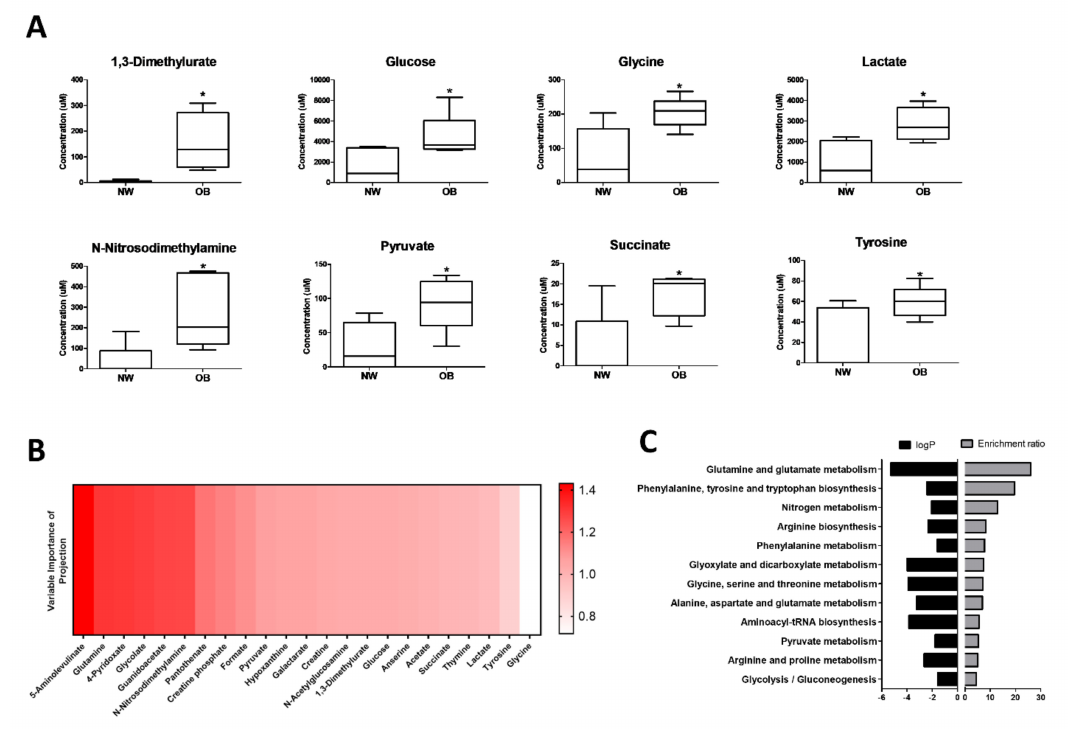
Figure 1. NMR spectroscopy reveals different metabotypes between obese and normal-weight OA patient synovial fluid ( A ) Concentration ( µ M) of selected metabolites that was found to be significantly different in synovial fluid from obese (OB; n = 5) and normal-weight (NW; n = 6) OA patient synovial fluids. * = p < 0.05; ( B ) top metabolites ranked on Variable Importance in Projection (VIP) score between obese (OB; n = 5) and normal-weight (NW; n = 6) OA synovial fluid; ( C ) enrichment analysis using MetaboAnalyst, of metabolites with VIP scores ≥ 1 between obese and normal-weight synovial fluids, showing enrichment ratio and associated p -values for the most relevant metabolic